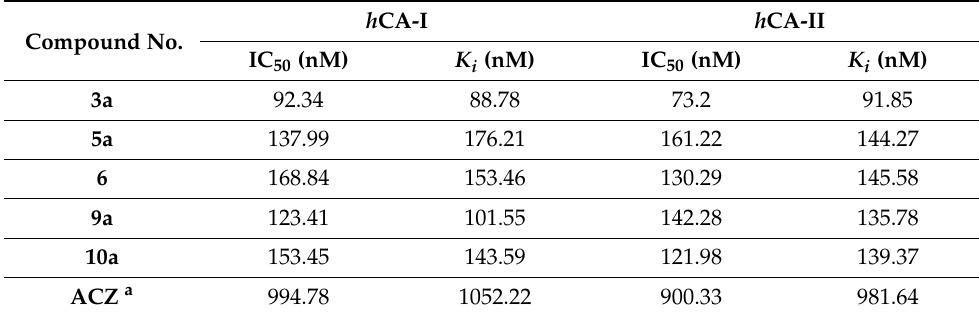
Table 4. The enzyme inhibition data of human carbonic anhydrase isoenzymes (hCA-I and -II) with the most active pyrazole, pyrazolo[1,5- a ]pyrimidine derivatives, and Acetazolamide. Compound